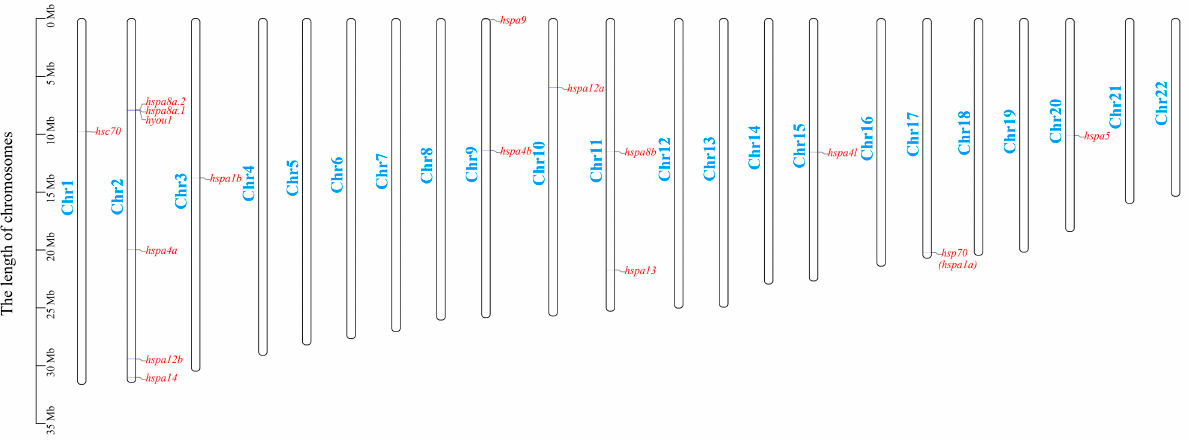
Figure 2. Chromosomal distribution of HSP70 genes in S. maximus . The HSP70 genes and chromo- somes are highlighted in red and blue, respectively. Table 2. Ka , Ks , and Ka / Ks ratios of duplicated HSP70 gene pairs.